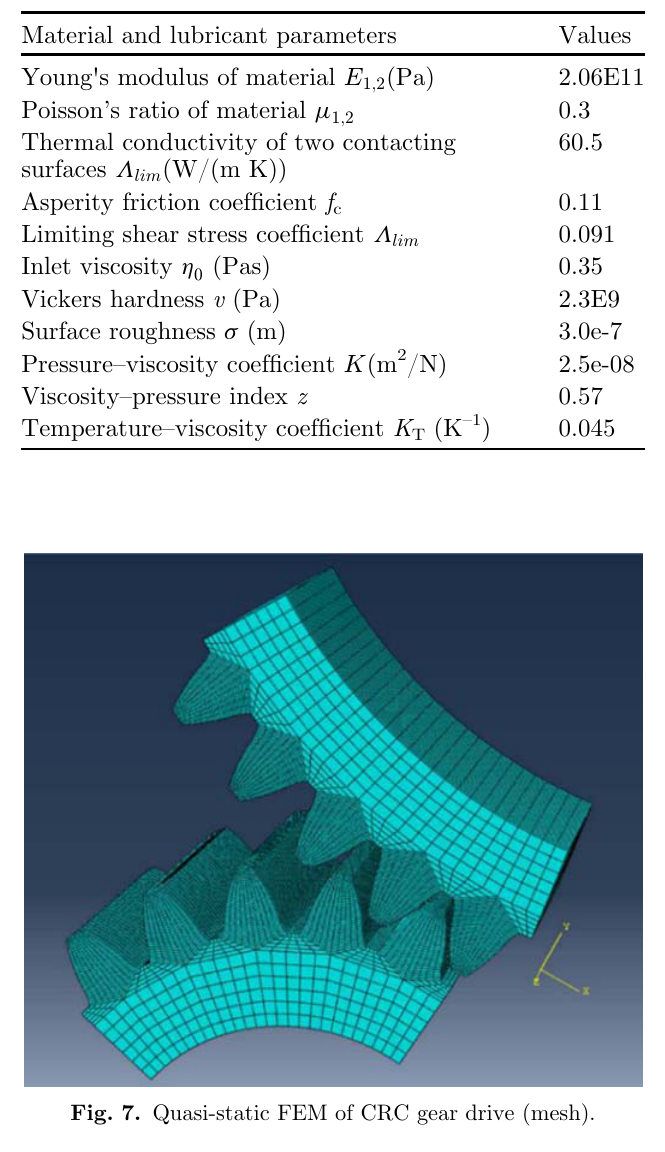
Table 2. Material and lubricant parameters for CRC gear drive.